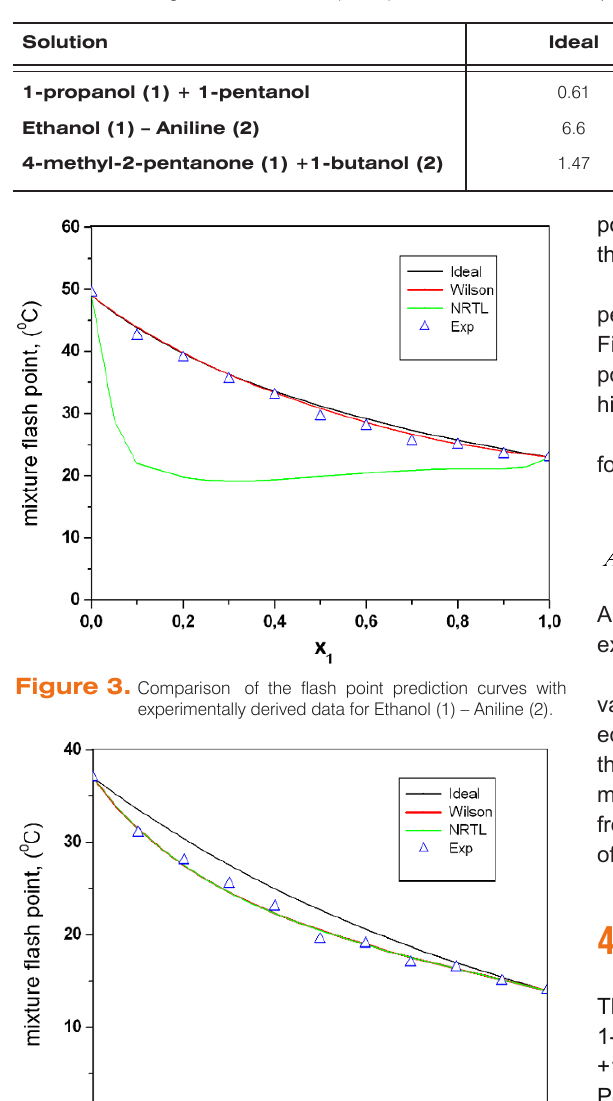
Table 6. Average absolute deviation (A.A.D.) between calculated and experimental flash points.